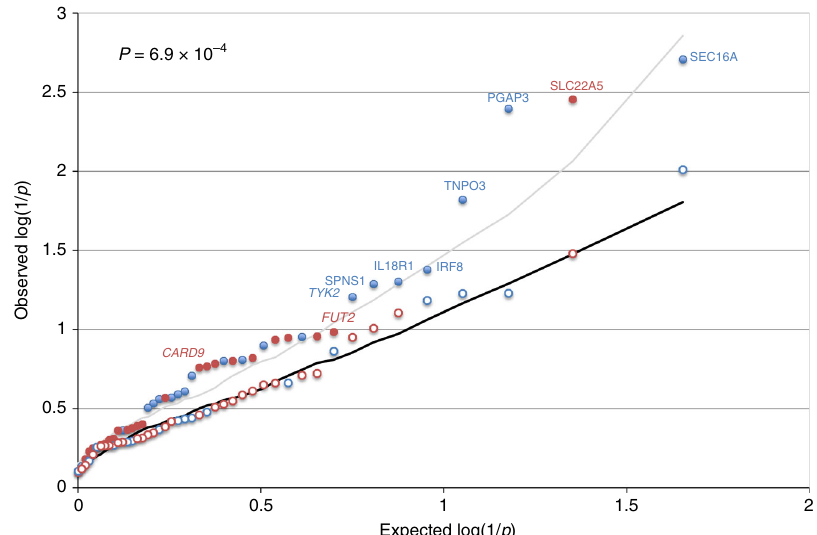
Fig. 9 QQ-plot for the gene-based burden test. Ranked log(1/ p ) values obtained when considering LoF and damaging variants (full circles), or synonymous variants (empty circles). The circles are labeled in blue when the best p value for that gene is obtained with CAST, in red when the best p value is obtained with SKAT. The black line corresponds to the median log(1/ p ) value obtained (for the corresponding rank) using the same approach on permuted data (LoF and damaging variants). The gray line marks the upper limit of the 95% con fi dence band. The name of the genes with nominal p value ≤ 0.05 are given. Known causative genes are italicized. The inset p value corresponds to the signi fi cance of the upwards shift in log(1/ p ) values estimated by